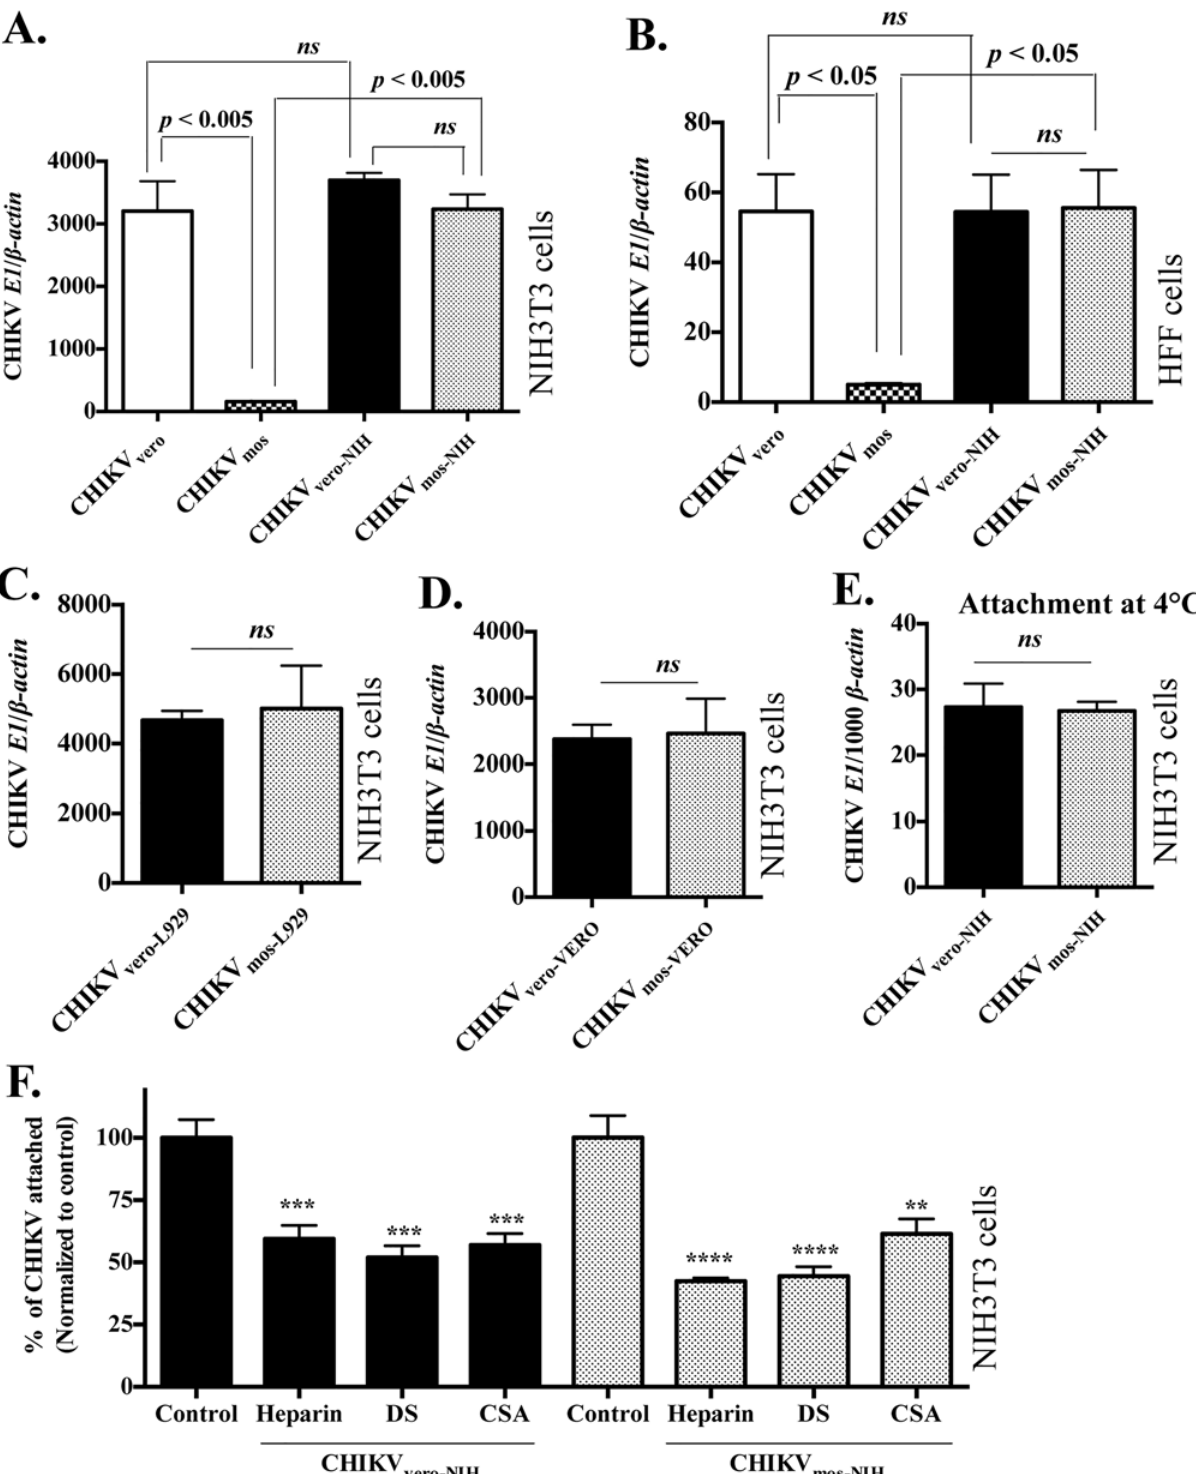
Fig 7. CHIKV mos infectivity can be enhanced after replication in mammalian cells. The viral stocks of CHIKV vero-NIH3T3 and CHIKV mos-NIH3T3 were prepared after CHIKV vero or CHIKV mos (Ross strain, MOI = 1) replicated in NIH3T3 for 48 h. (A) NIH3T3 and HFF cells (B) were infected with CHIKV vero , CHIKV mos , CHIKV vero-NIH3T3 and CHIKV mos-NIH3T3 (MOI = 1), and viral RNA copy numbers were measured at 24 h by RT-qPCR. Data represents ratio of copy number of CHIKV E1 to β -actin . (C) NIH3T3 cells were infected with CHIKV vero-L929 and CHIKV mos-L929 (MOI = 1), and viral RNA copy numbers